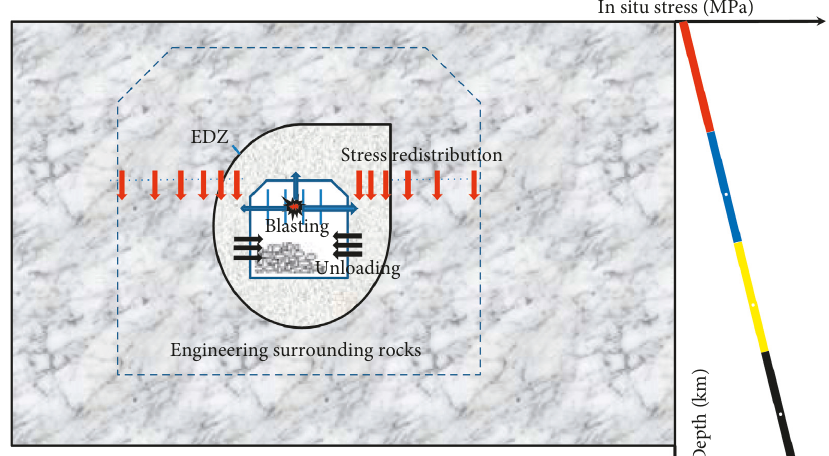
Figure 1: A static-dynamic stress situation of underground engineering surrounding